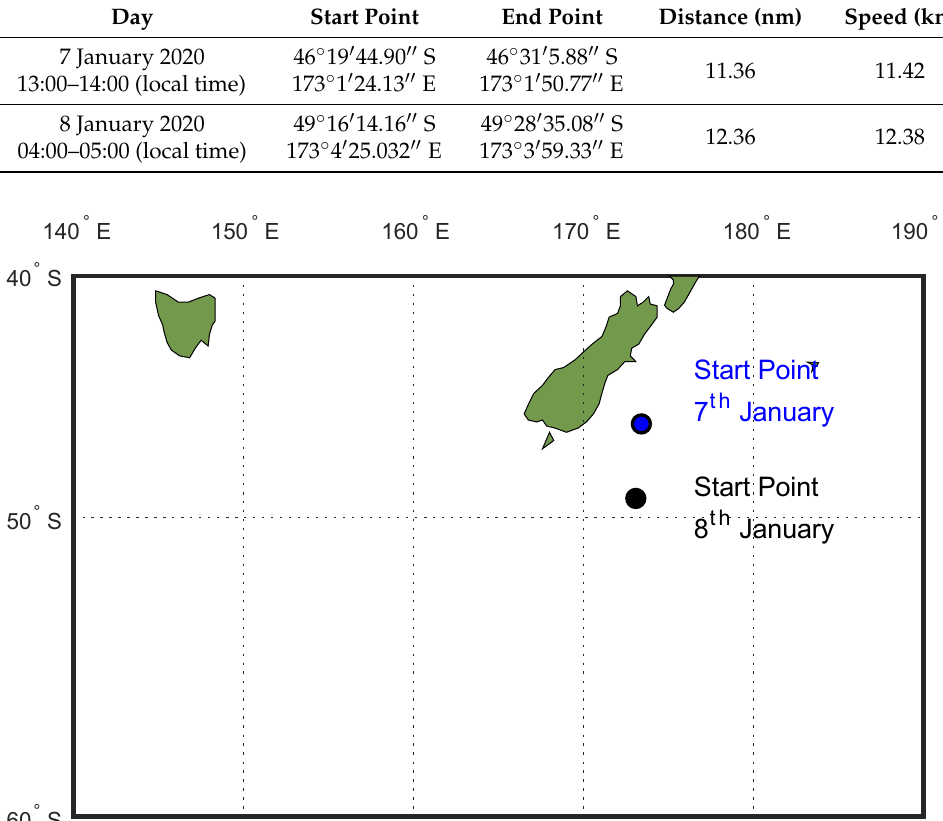
Figure 2. Ship’s starting position during the data collection events.